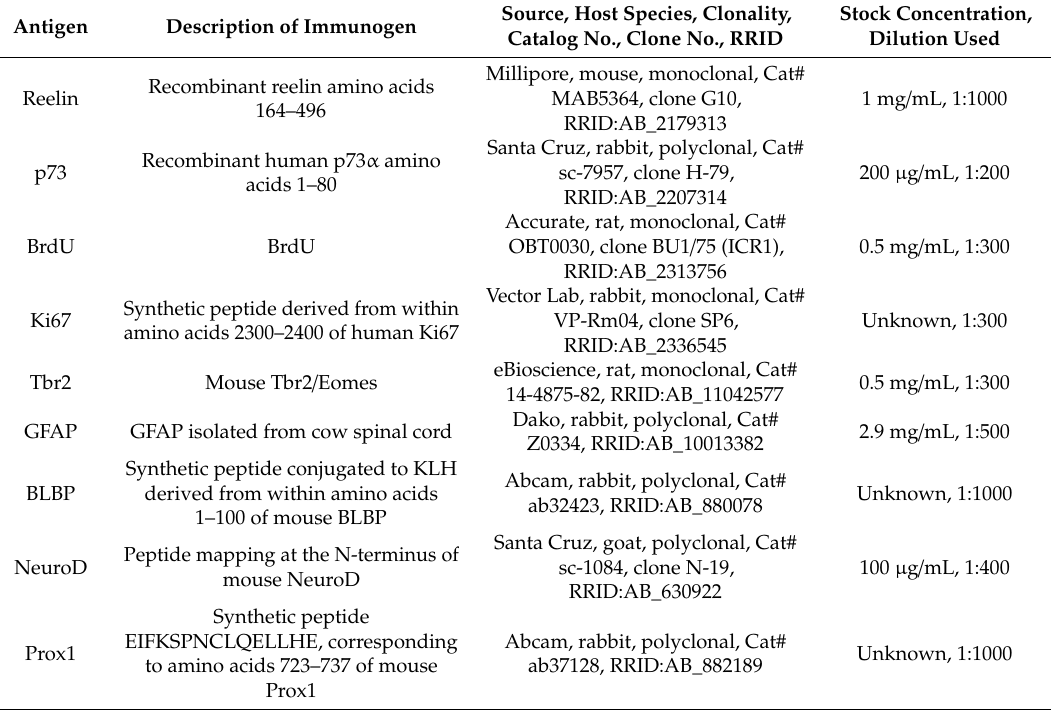
Table 1. List of primary